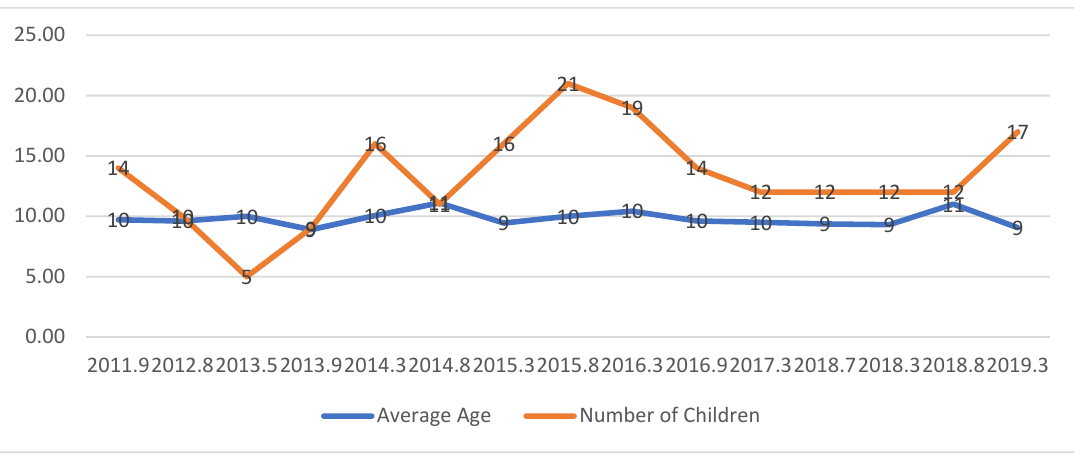
Figure 4. Distribution of attendance over 15 church camps (n = 66).